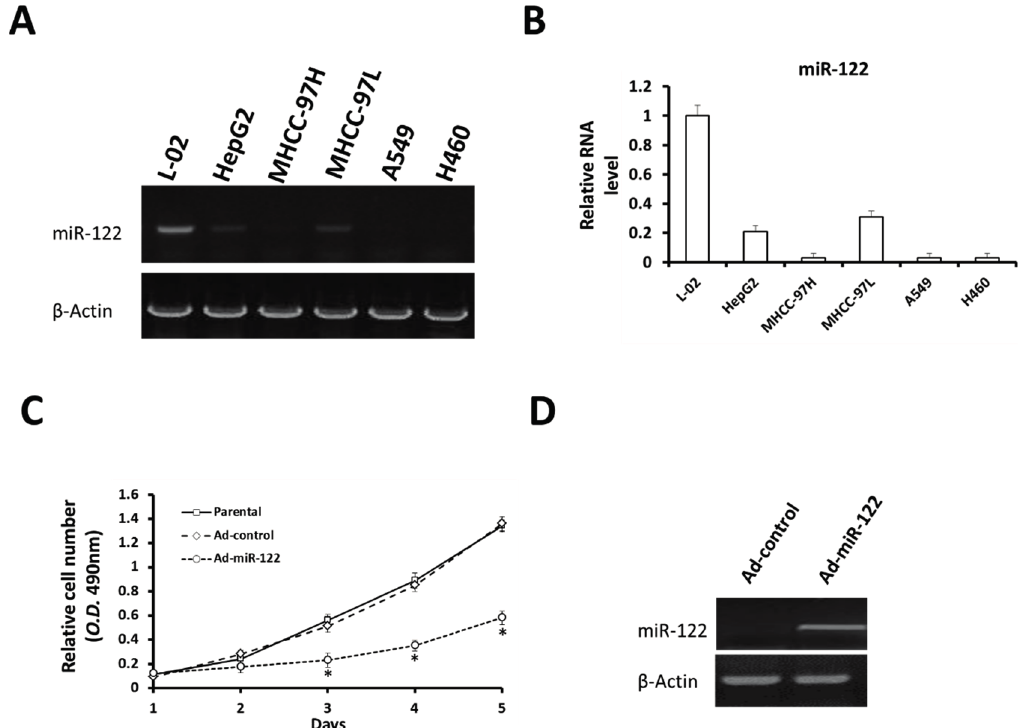
Figure 1. MiR-122 expression is detected in hepatocyte cells but not NSCLC cells and the expression of miR-122 via adenoviral vector inhibits the proliferation of A549 cells. ( A ) Total RNA extracted from the indicated cell lines were analyzed by Real time RT-PCR, and β -actin was chosen as loading control; ( B ) Relative RNA level was shown as mean ± SD from triplicate measurements with similar results; ( C ) A549 cells, which were infected with control or Ad-miR-122, were harvested at the indicated time points. Relative cell number was determined by MTT assay; ( D ) The level of miR-122 in A549 cell was shown. * p < 0.05 versus Ad-control or